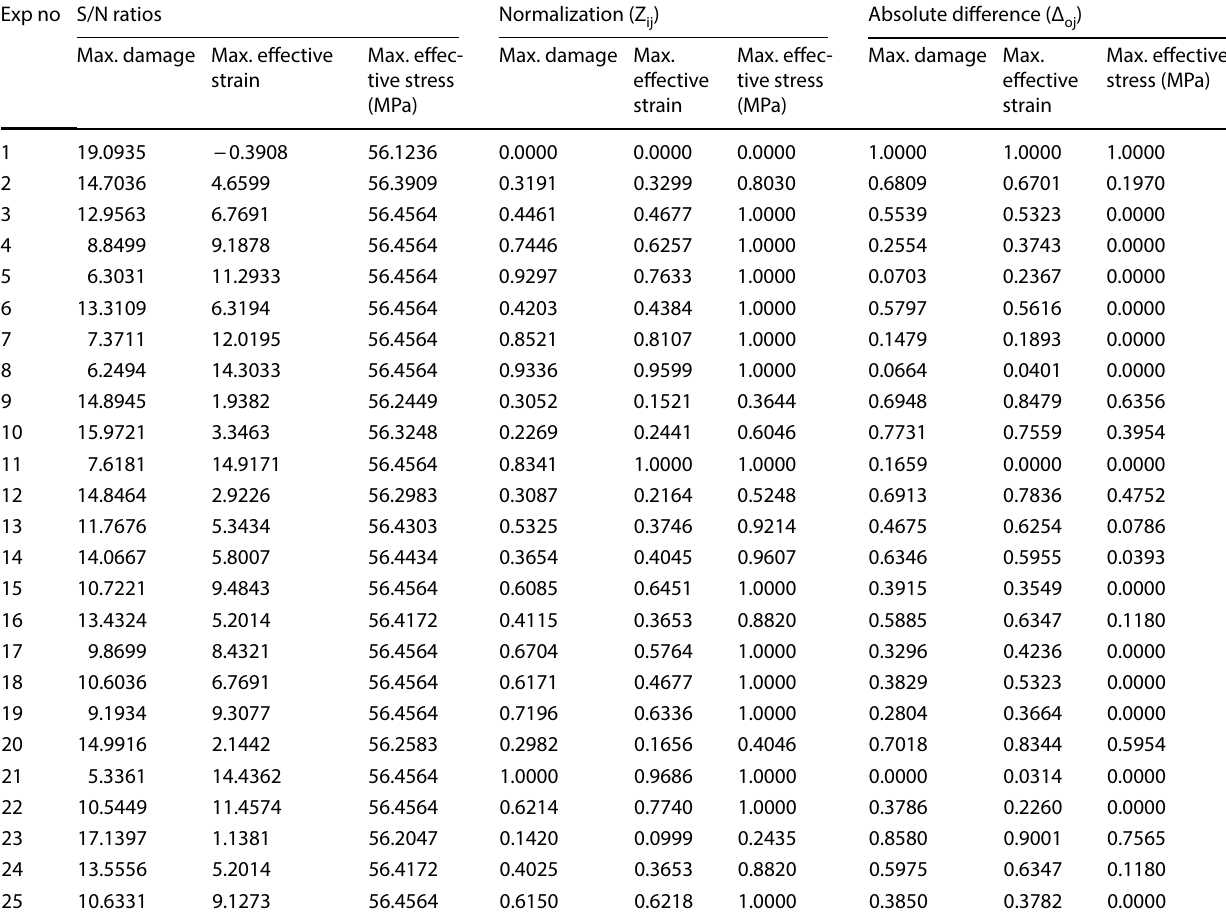
Table 4 Values of S/N ratio, normalized S/N and absolute difference Exp no S/N ratios Normalization (Z